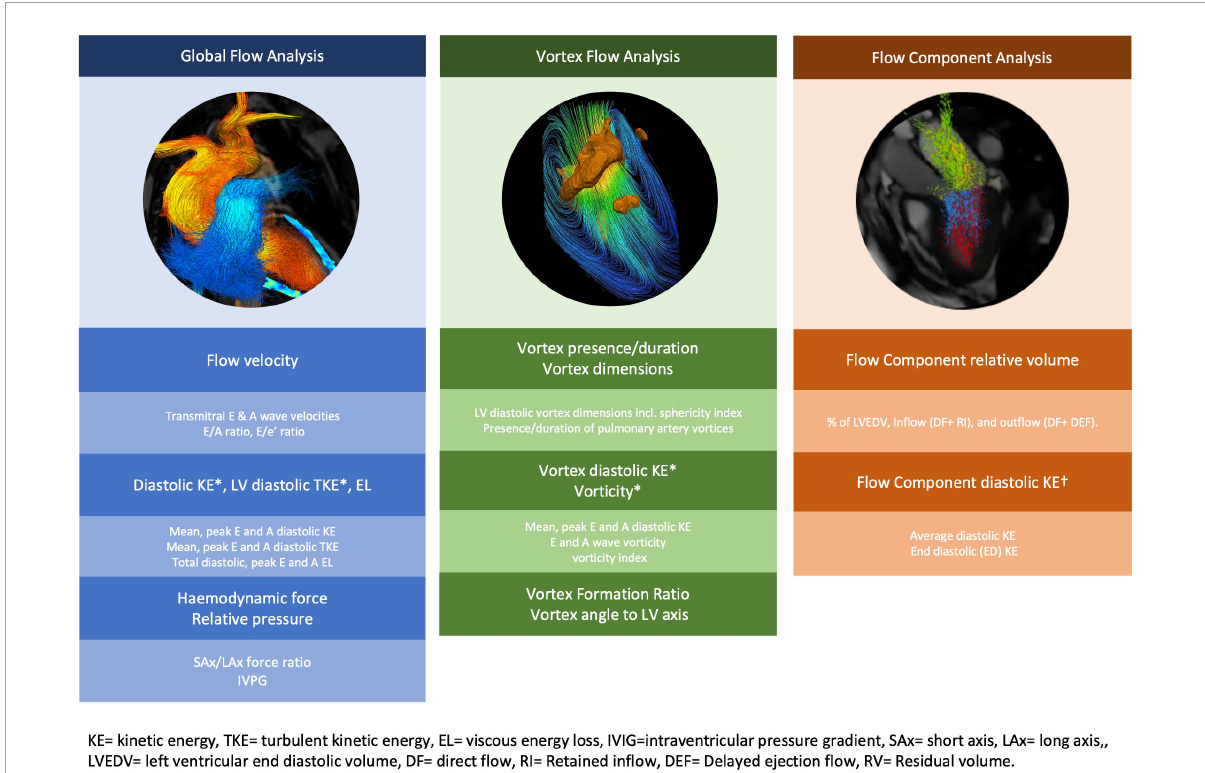
FIGURE1 Novel 4D flow CMR parameters of left ventricular diastolic function. Novel 4D flow CMR parameters are obtained from analysis of global flow, vortex flow and/or functional flow